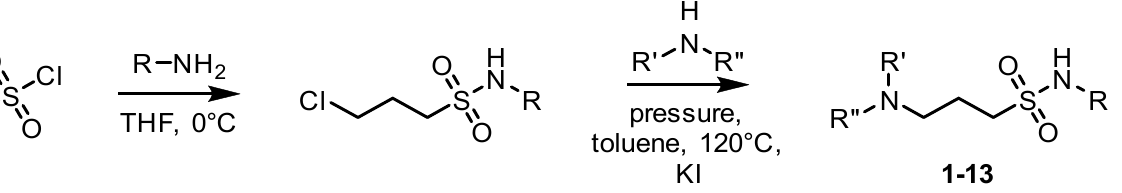
Figure 1. Chemical structures of homotaurine and curcumin.